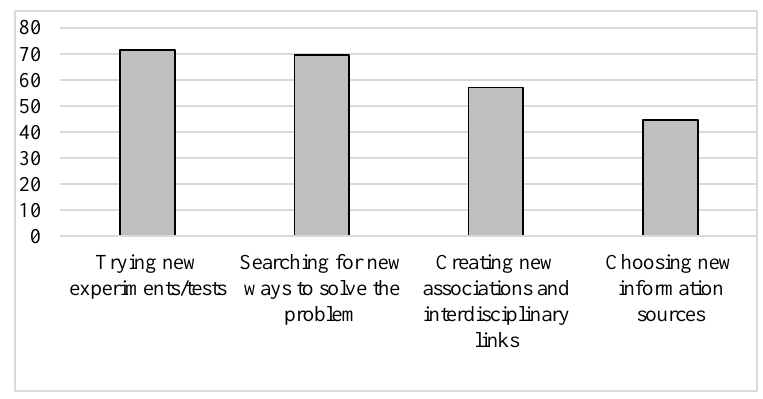
Fig. 6. Important creative thinking skills